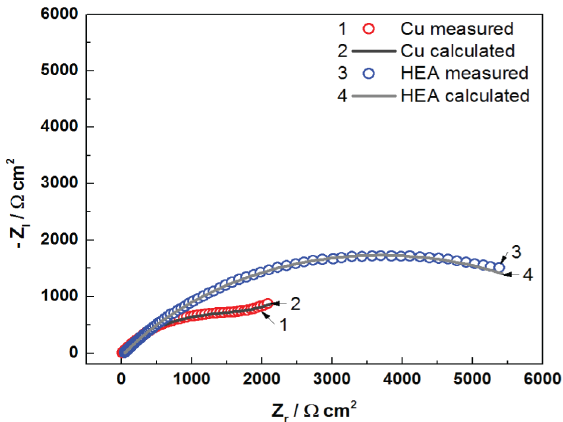
Figure 6. The Nyquist diagrams of the Cu and Cu/HEA electrodes in artificial seawater. Lines represent the modeled data according to the EECs from Figure 7.